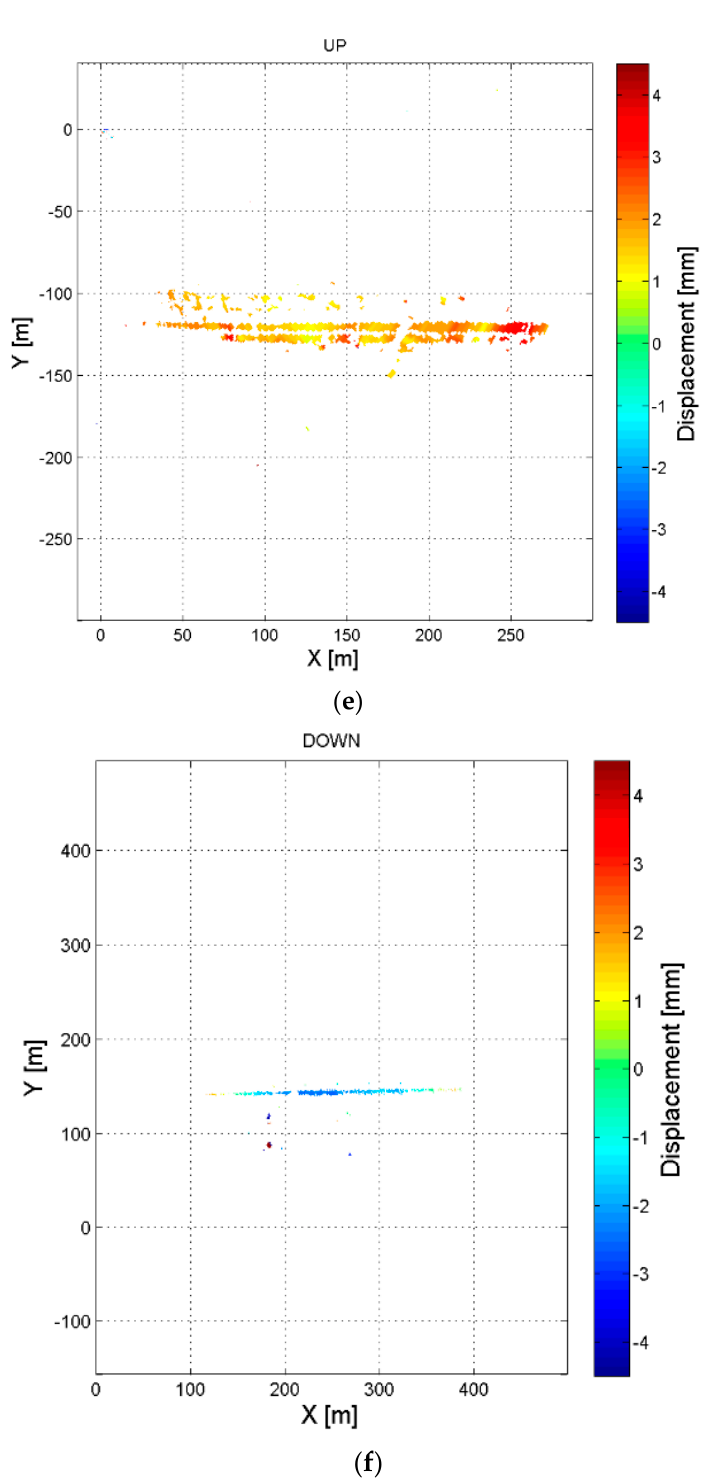
Figure 12. San Pietro dam, Aquilonia. ( a , b ) photo of the dam as observed from the GBSAR positions; ( c , d ) interferometric coherence; ( e , f ) displacement maps in Cartesian coordinates. Data have been collected by two GBSAR systems installed on upper (UP) and downstream (DOWN) sides of the dam, respectively.